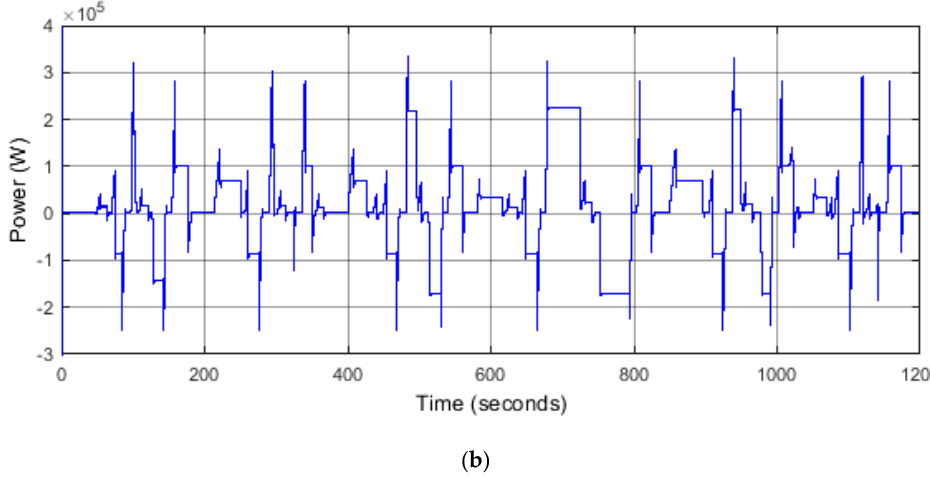
Figure 2. ( a ) Quite power profile; ( b ) Busy power profile.